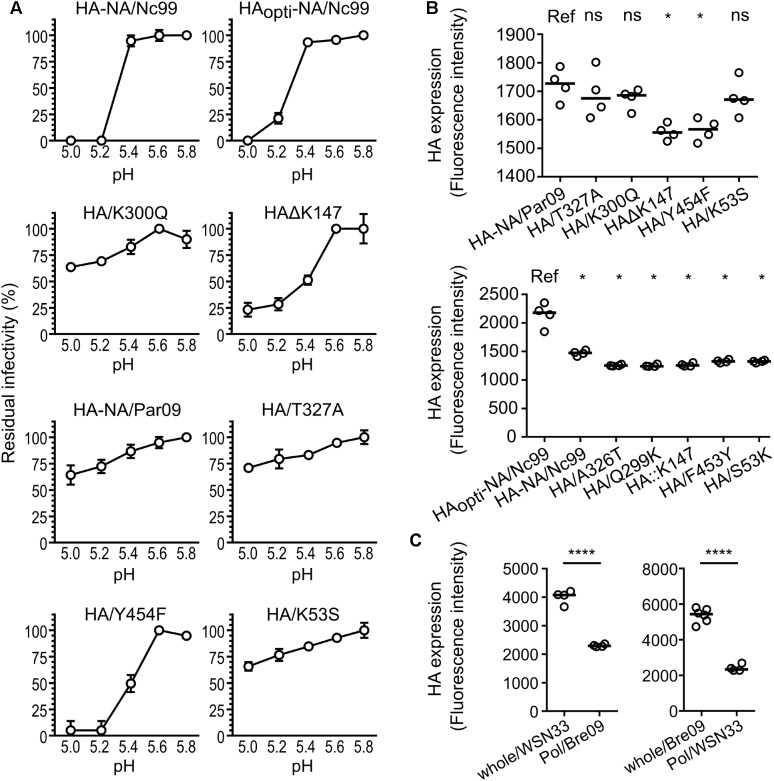
Virus stability to lower pH exposure and HA expression in infected cells. (A) H1N1 reassortant viruses either with a 1999 HA (wild-type or optimized) or a 2009 HA (wild-type or with a single amino acid substitution) were exposed to pH-adjusted PBS buffer for one hour and the residual infectivity values (in percentage from the initial TCID50 titer) were calculated. Spheres represent the mean residual infectivity and vertical lines represent the standard deviation (N = 3). (B,C) HA surface expression in infected MDCK cells analyzed by flow cytometry detecting Alexa Fluor 488 signal 24 h after infection. Horizontal lines represent the median of fluorescence intensities and HA surface expression levels were compared using a Wilcoxon–Mann–Whitney test (ns, P > 0.05; ∗P < 0.02; ∗∗∗∗P < 0.0001).